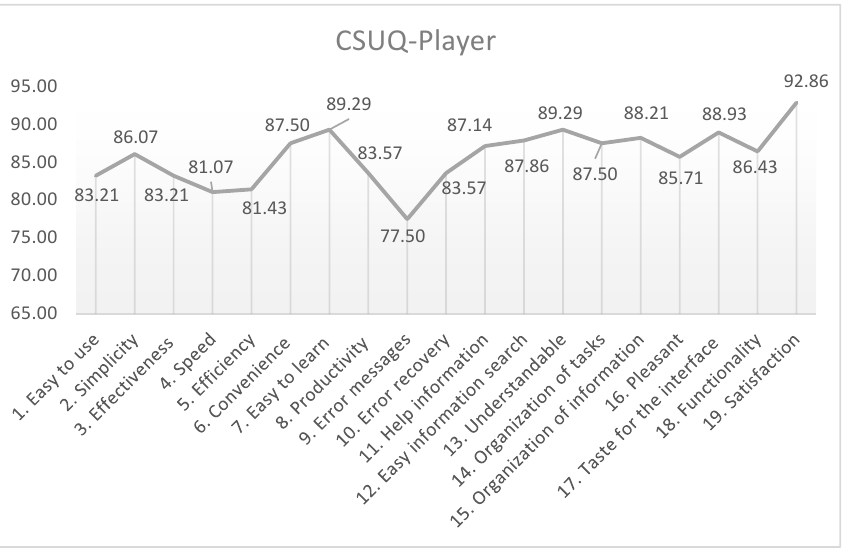
Figure 22. Player Role Answers-Averages per CSUQ Question.